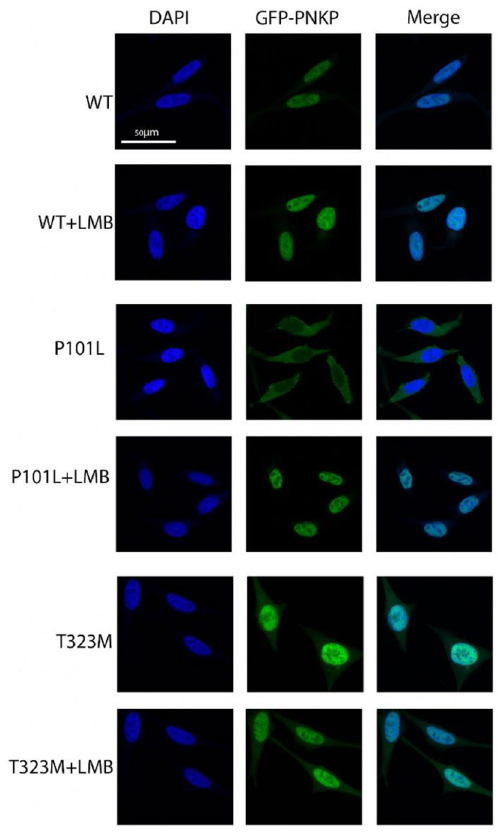
Figure 4. Inhibition of exportin 1 leads to nuclear retention of P101L PNKP. Stably-transfected PNKP- knockout HeLa cells expressing GFP-tagged wild-type and mutant PNKP were treated with leptomycin B (LMB) for 3 h and then stained with DAPI and imaged at 40 ×